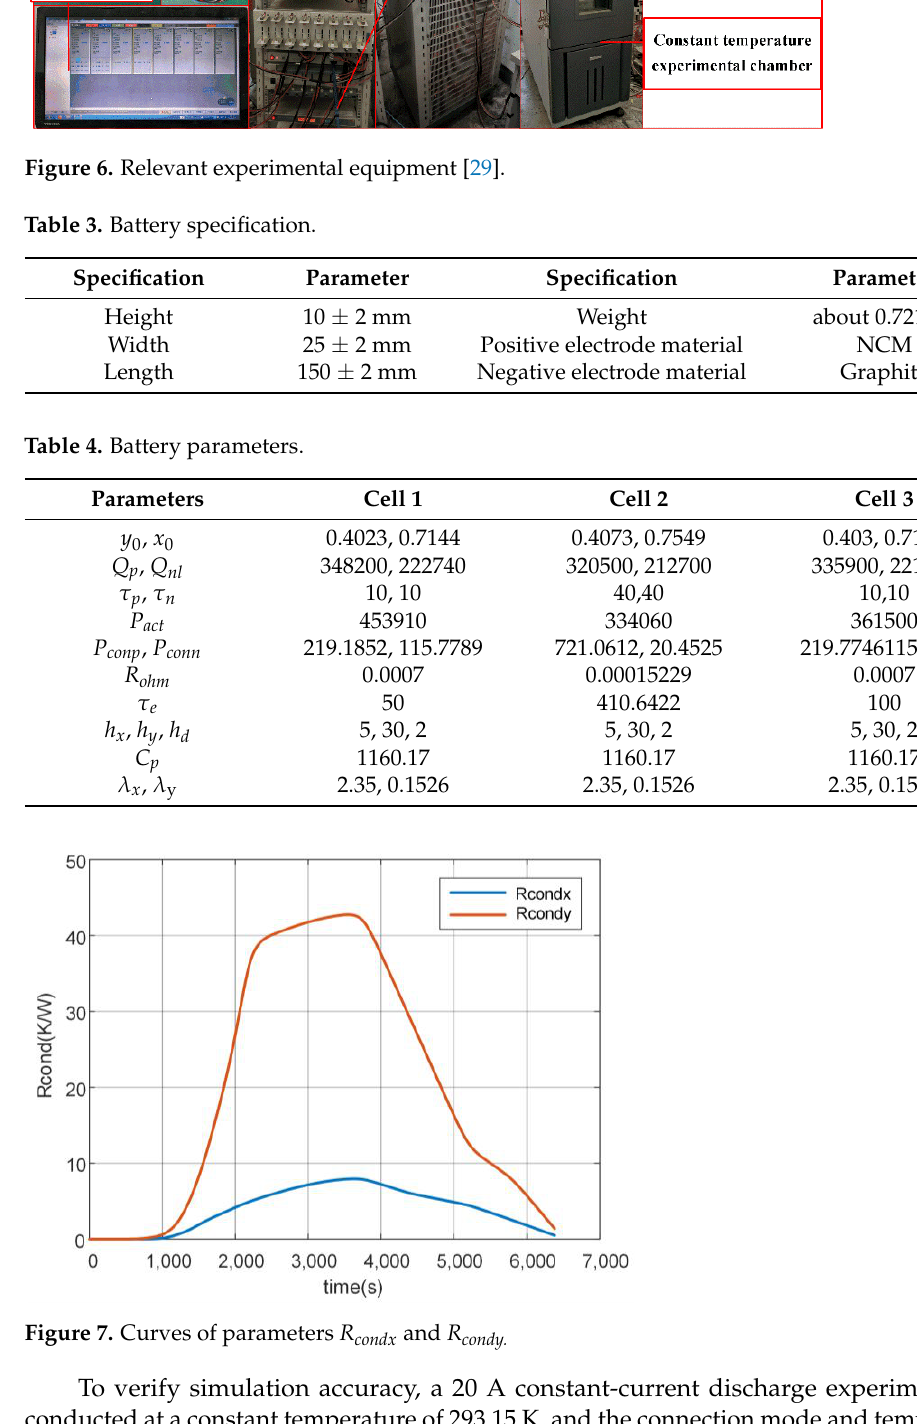
Figure 8. Battery pack and temperature acquisition point arrangement. The comparison of terminal voltage and temperature is shown in Figure 9. The mean absolute errors are shown in Table 5. ( a )